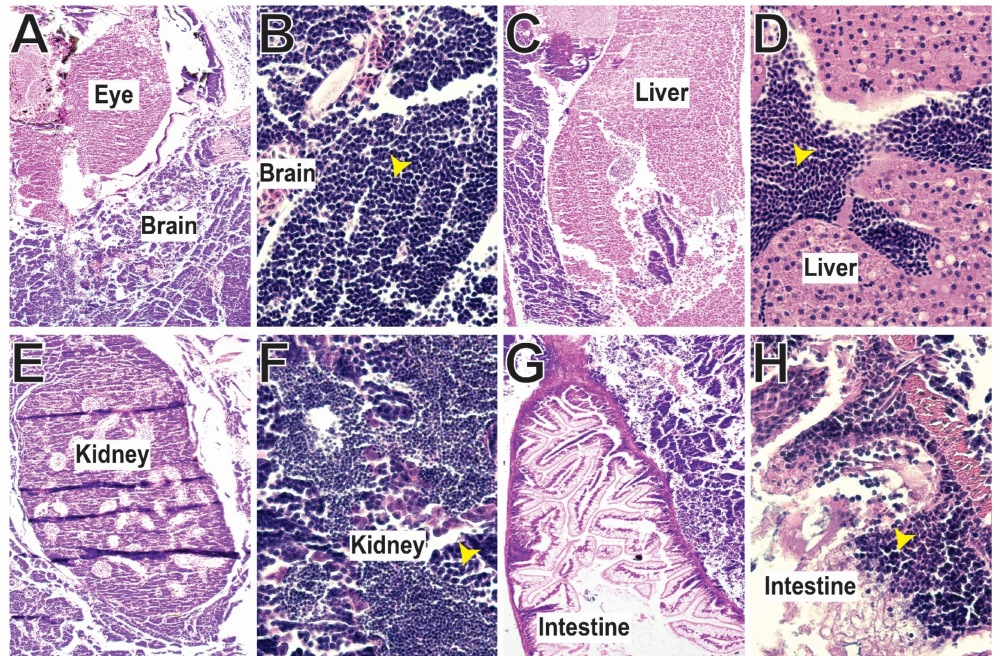
Figure 5. Analysis of lymphocytic leukemia in zebrafish harboring SCID-derived JAK3 mutations. Histology of organs from afflicted zebrafish showing leukemic infiltration into the brain ( A , B ), liver ( C , D ), kidney ( E , F ) and intestine ( G , H ) in representative jak3 mutant fish at 12 months post fertilization imaged at 10 × ( A , C , E , G ) and 40 × ( B , D , F , H ) magnification. Yellow arrowheads indicate leukemic cell